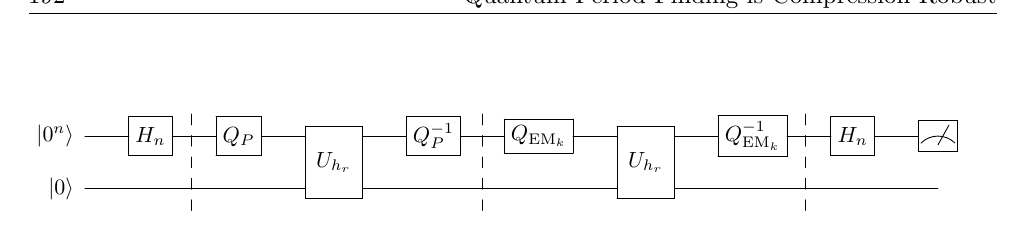
Figure 3: Quantum circuit Q HS for a Hashed-Simon -Attack on Even-Mansour